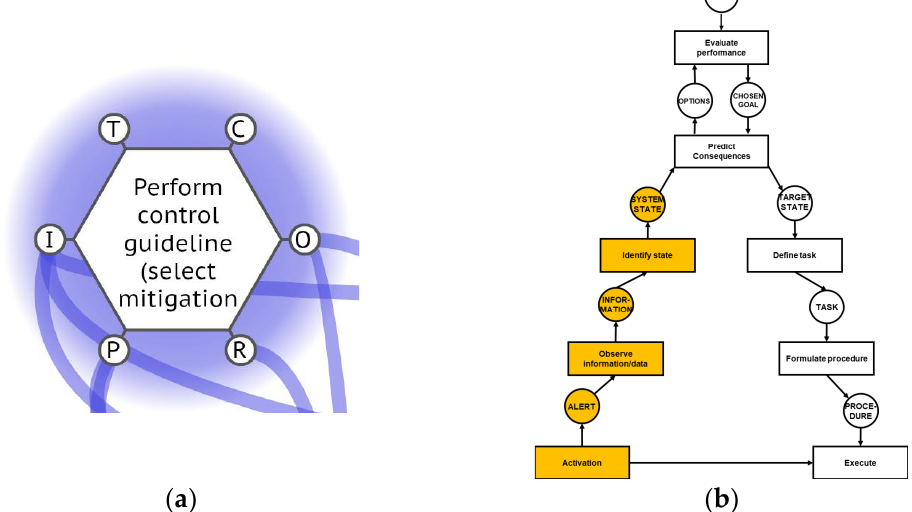
Figure 4. An example of FRAM and decision ladder mapping: ( a ) A FRAM function (F.1) and ( b ) Mapping of the function into decision ladder, marked in yellow.